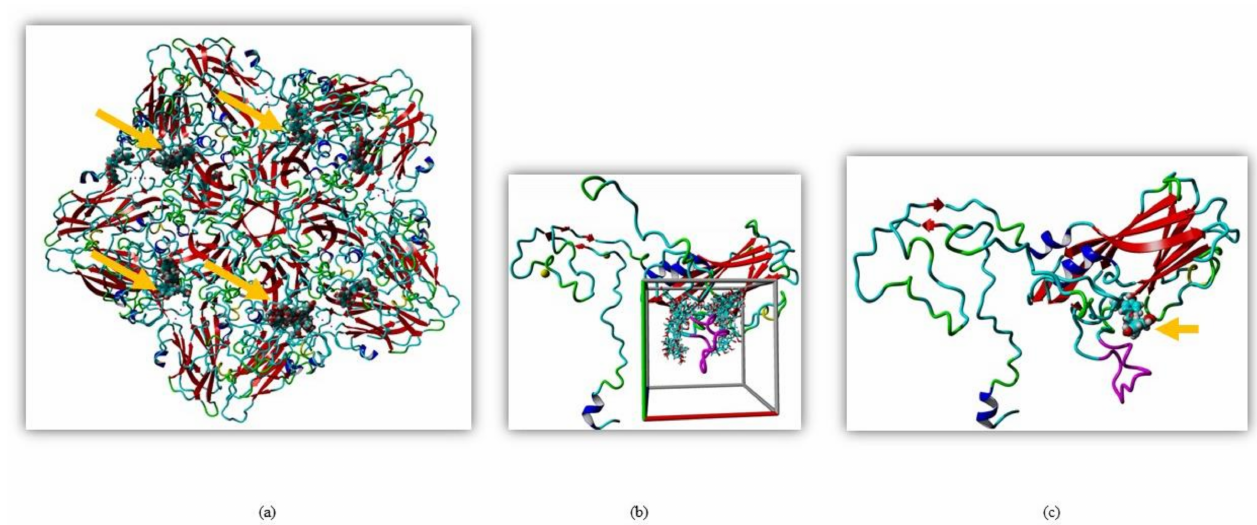
Figure 1. Molecular docking of silymarin with EV-A71 ( a ) Silymarin interacted with VP1 when docked on the crystal structure of EV-A71 (PDB ID: 4YVS). ( b ) Global docking of silymarin with homology modeled VP1 of EV-A71 (strain 41). The cubic cell represents specific docking near the GH loop. ( c ) Silymarin in best docking confirmation with homology modeled VP1 of EV-A71 (strain 41). The arrow indicates silymarin interacting with the GH loop